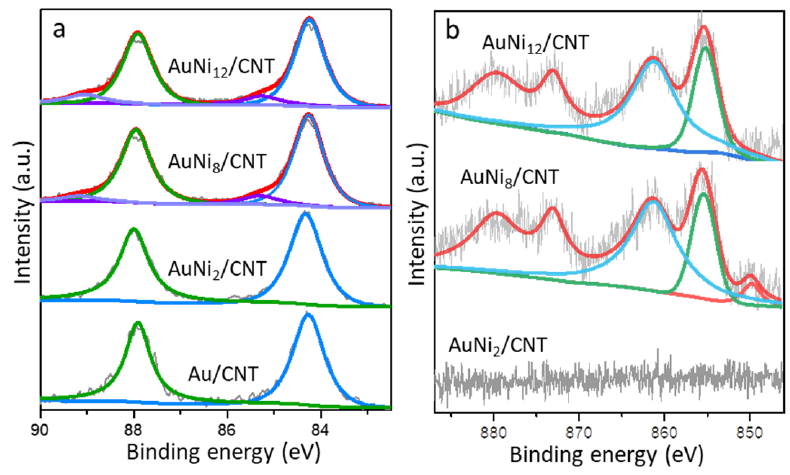
Figure 6. XPS spectra of the Au 4 f ( a ) and Ni 2 p ( b ) core level in typical catalysts. The XPS signal in the Ni 2 p core level is not observed in AuNi 2 /CNT with low Ni/Au atomic ratio (Figure 6b). In the typical AuNi 8 /CNT sample, the overlapped characteristic peaks can be deconvoluted into two peaks at 850.1 and 855.3, corresponding to the presence of Ni 0 and Ni 2+ , respectively [34]. The broad peak at 861.3 eV is ascribed to the satellite peak of Ni 2+ . However, only Ni 2+ in oxidative state exists on the surface of AuNi 12 /CNT, and metallic Ni 0 species is no longer detected. The surface information in Table S1 suggests the higher Au/C surface weight ratio of 2.9–3.3 wt% compared to the theoretical value (1.5 wt%) in different catalysts. It mainly results from the high dispersion of 2–6 nm Au particles on the outside surface of CNT, which could be mostly detected by the XPS technique applied to the CNT walls (diameter of 12 ± 4 nm). The surface atomic ratios between Ni and Au are 11.2 and 14.8 in the typical AuNi 8 /CNT and AuNi 12 /CNT catalysts. The slightly increasing Ni/Au ratio compared with the theoretical value (8:1 for AuNi 8 /CNT and 12:1 for AuNi 12 /CNT) reflects the higher surface distribution degree or smaller sizes of Ni than Au species. Concerning the XRD results and the synthesis method, it is inferred that Ni component is distributed on the surface of CNT mainly in the form of nickel oxide instead of forming uniform alloy with Au. However, metallic Ni 0 is detected in the AuNi 8 /CNT, and the lattice constraint appears on the surface of Au nanoparticles as observed by XRD and high-resolution TEM images. The formation of small percentage of Ni 0 in the AuNi 8 /CNT is consistent with the assumption that a few Ni atoms permeate into the sub-layer of Au particles. The even higher Ni/Au ratio in AuNi 12 /CNT results from the extrusion of Ni atoms to form NiO fractions surrounding Au particles, as revealed by the HAADF-STEM elemental mappings. The XPS spectra of O 1 s region is shown in Figure 7a. The O 1 s spectrum in the monometallic Au/CNT reference is deconvoluted into three peaks locating at 531.4, 532.4, and 533.8 eV, which are assigned to C=O, O-C=O, and C-O groups (Figure S3) [35], re- spectively. The O 1 s signal in the AuNi 2 /CNT displays nearly identical distribution of oxygen species to Au/CNT. It is noteworthy that the AuNi 8 /CNT exhibits an additional peak located at 529.6 eV, ascribed to the lattice oxygen species supplied by oxidative nickel species [36]. The percentage of lattice oxygen species in AuNi 12 /CNT further raises due to the accumulation of nickel oxide. It has to be admitted that lattice oxygen plays an essential role during the oxidation reactions driven by gold catalysts [37], and the better conversion of catalytic activity by AuNi x /CNT can presumably be